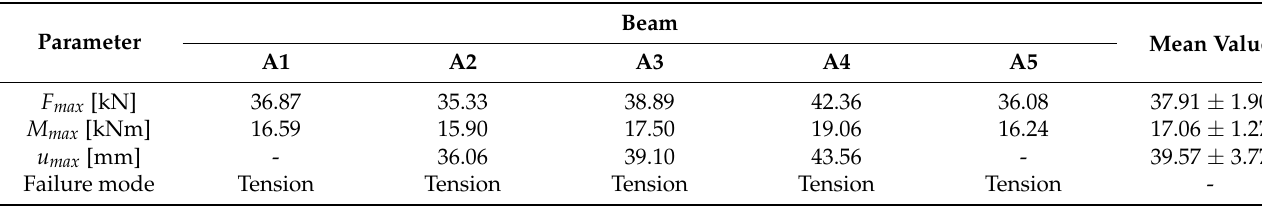
Table 5. Series A test results.